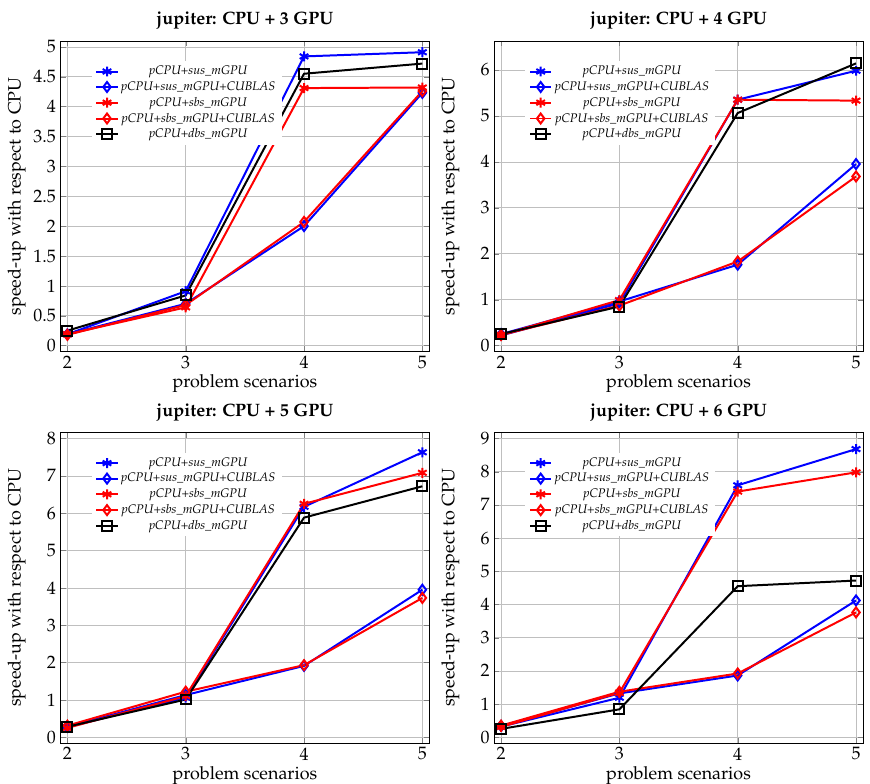
Figure 3. Evolution of the speed-up with respect to the homogeneous parallel version on CPU ( pCPU ) of different hybrid versions ( pCPU+xxx_mGPU ) when the problem size grows (Table 1). For different number of GPUs in jupiter.